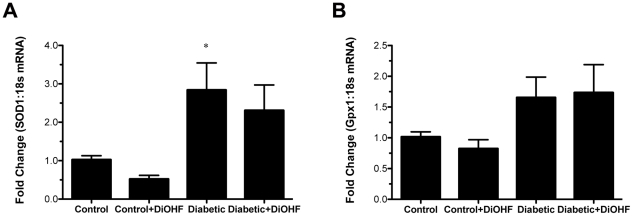
Intracellular antioxidants mRNA gene expression.(A) Measurement of Cu/Zn-superoxide dismutase (SOD1) and (B) gluthathione peroxidase (Gpx1) mRNA by real time RT-PCR, normalized to the housekeeping gene 18s. Diabetic rats demonstrated increased gene expression of SOD1 and Gpx1, which were not affected by DiOHF. Data expressed as mean ± SE. *P<0.001 vs control (non-diabetic) rats.